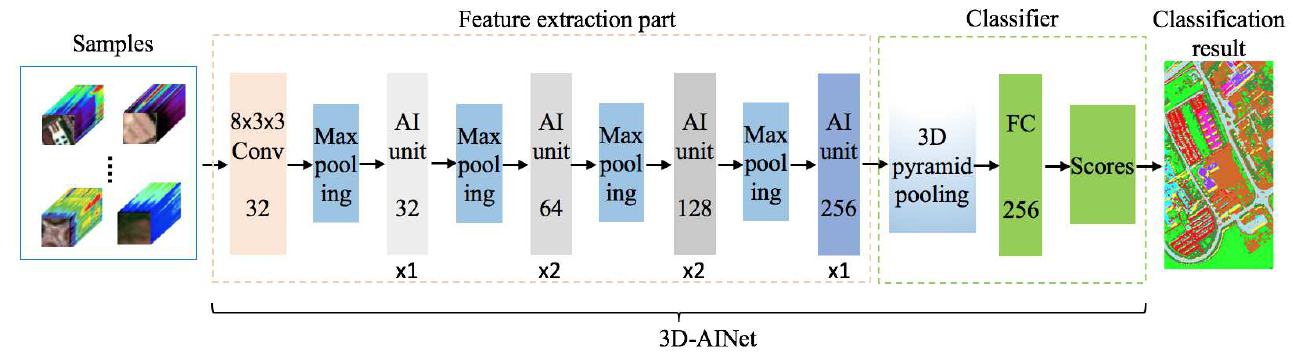
Figure 1. Framework of AINet. On the left, the L × S × S -sized samples from the neighborhood window centered around each target pixel are extracted, and then the samples are fed into AINet to extract deep spectral–spatial features. Finally, the classification scores are calculated by the